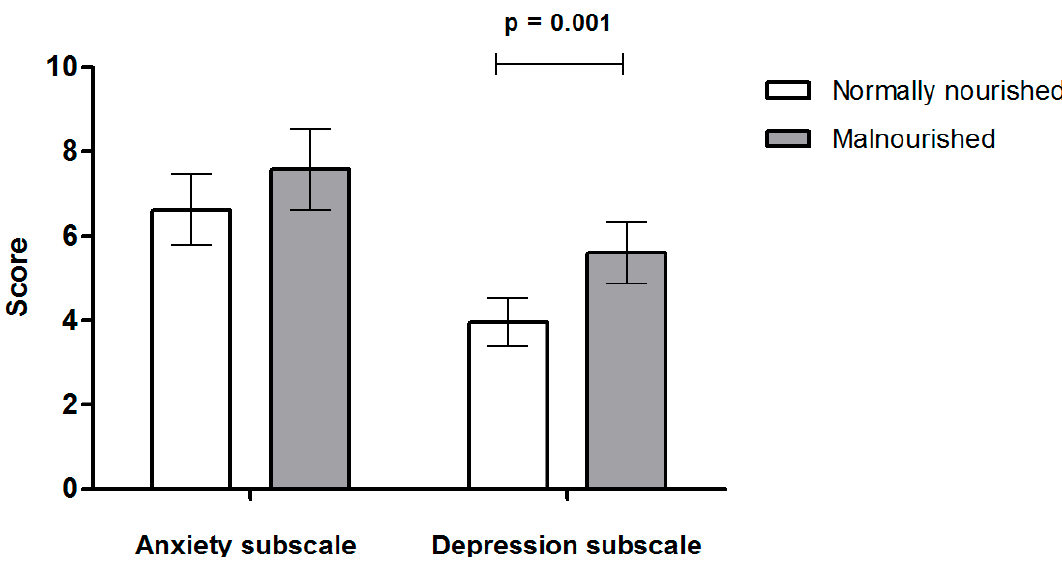
Figure 2. Association between malnutrition and HADS anxiety and depression subscales.